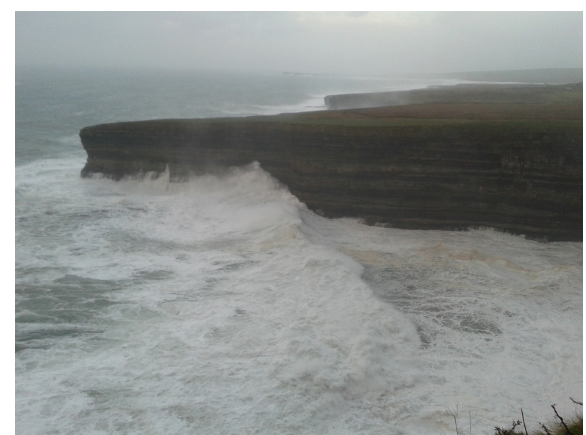
Figure 8. The sea condition as viewed from the platform at the Céide fields, Co. Mayo, on 10 December